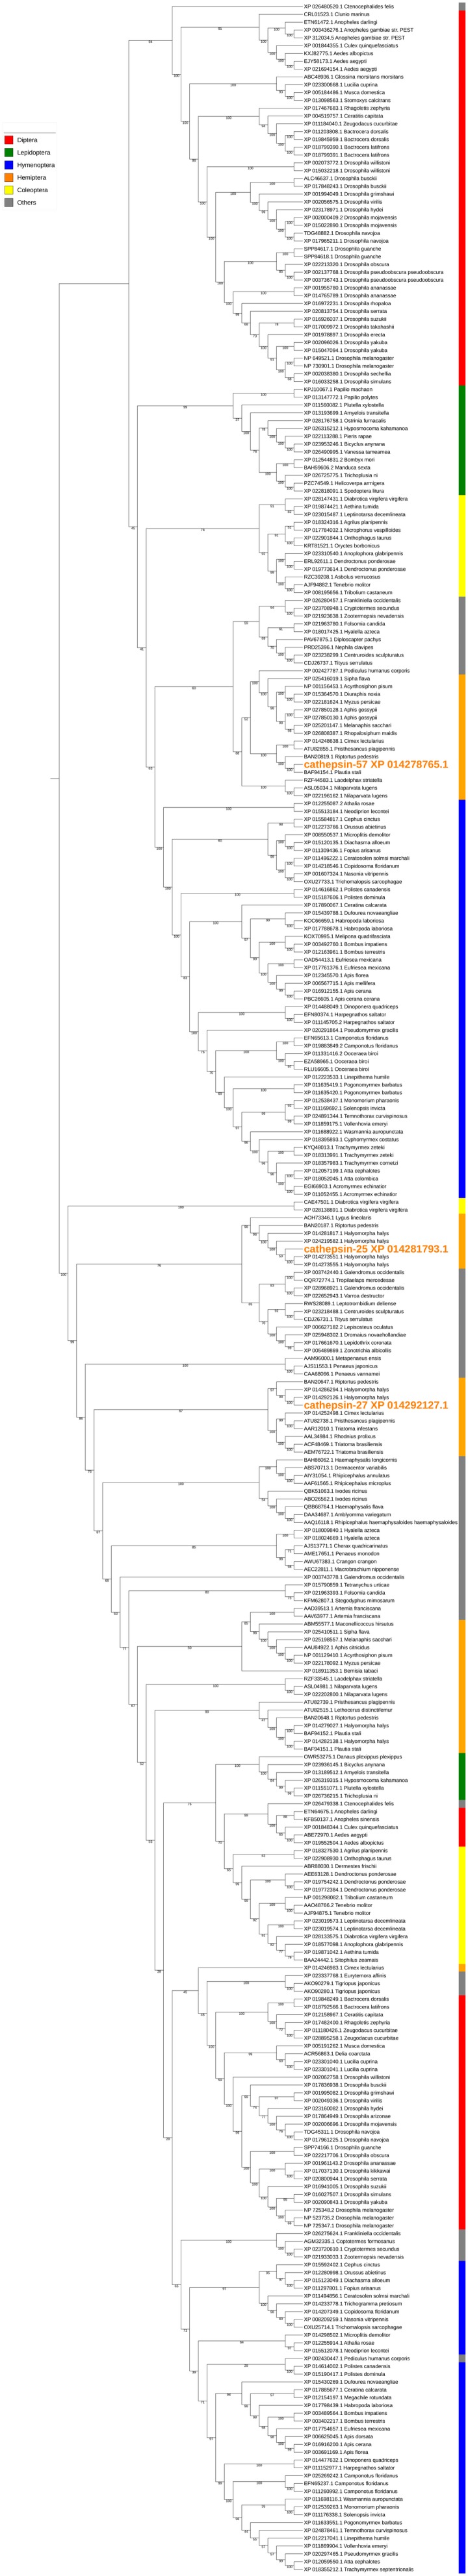
Phylogenetic analysis of amino acid sequences from cathepsins isolated from WS and SS. The positions of H. halys cathepsins−25, −27, and −57 in different clades are shown. Insect and “other” orders are indicated by color as shown. Branch numbers are bootstrap values (%) of >40%.